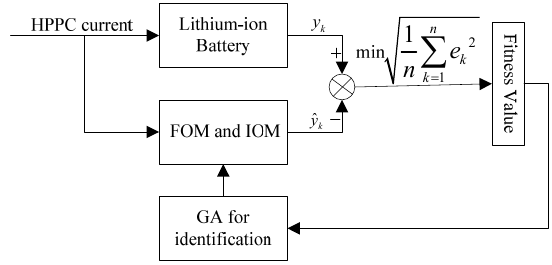
Figure 5. Parameter identification for lithium ‐ ion battery.